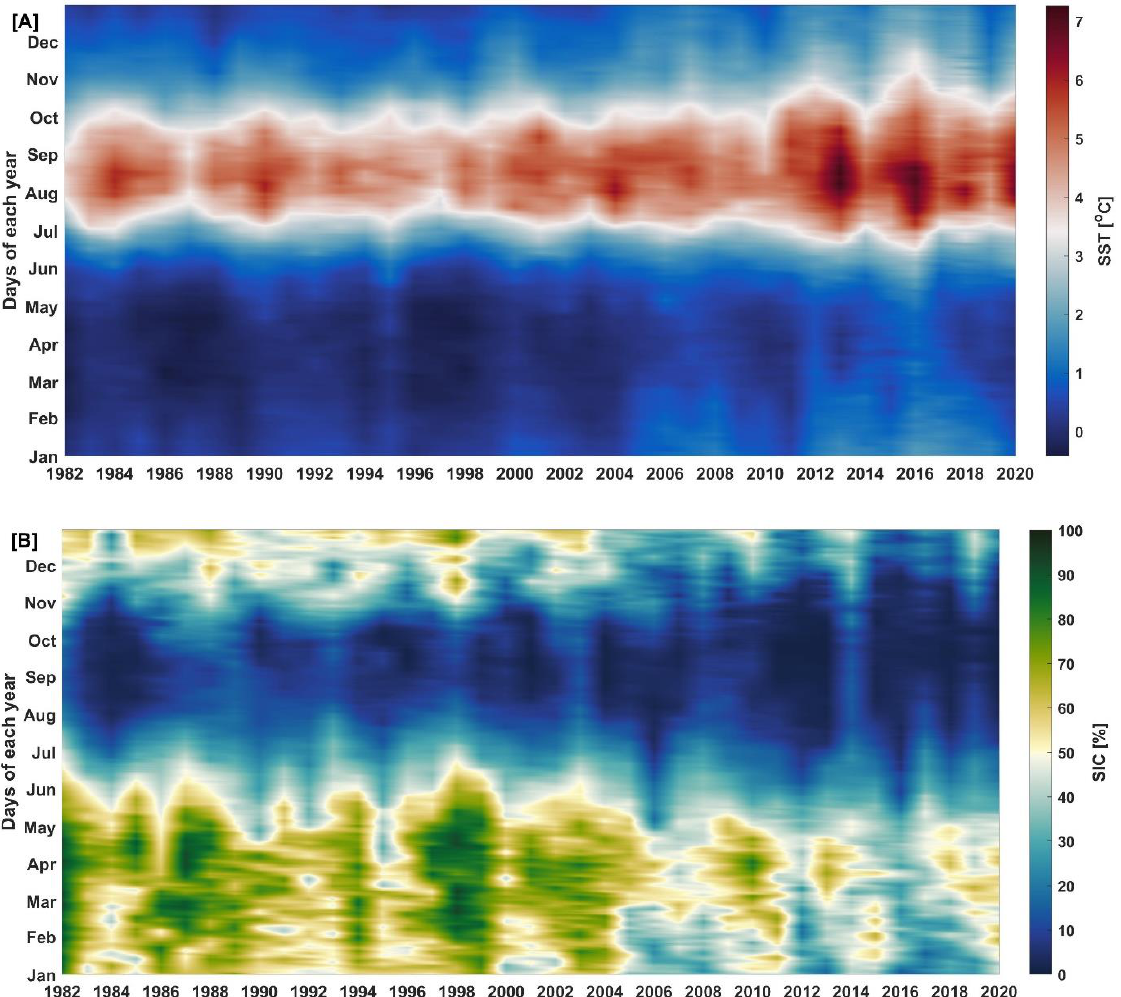
Figure 4. Spatially averaged daily SST ( A ) and SIC ( B ) with time indicating changes in the seasonal cycles during 1982 – 2020.